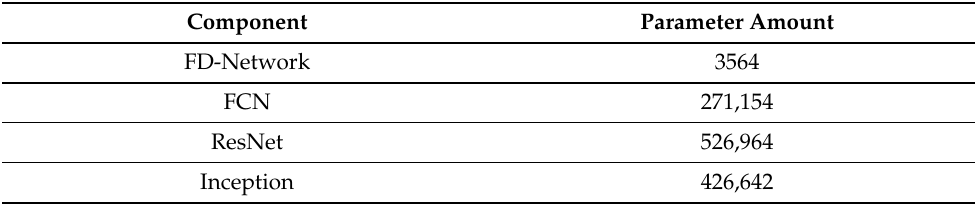
Table 3. The number of the learnable parameters for